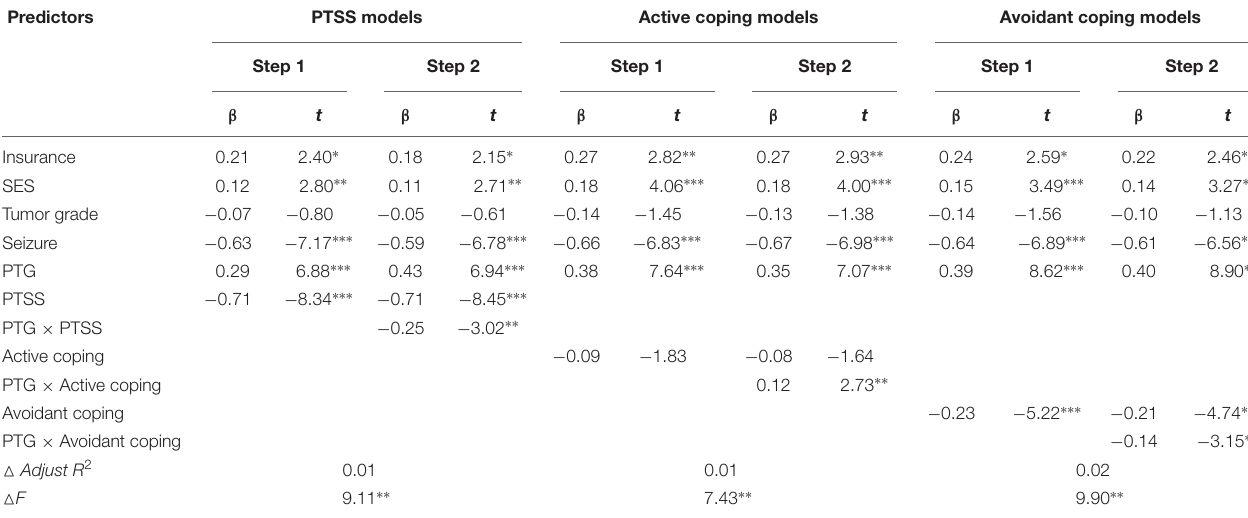
TABLE 3 | Standardized regression coefficients ( β ) of the predictors in different regression